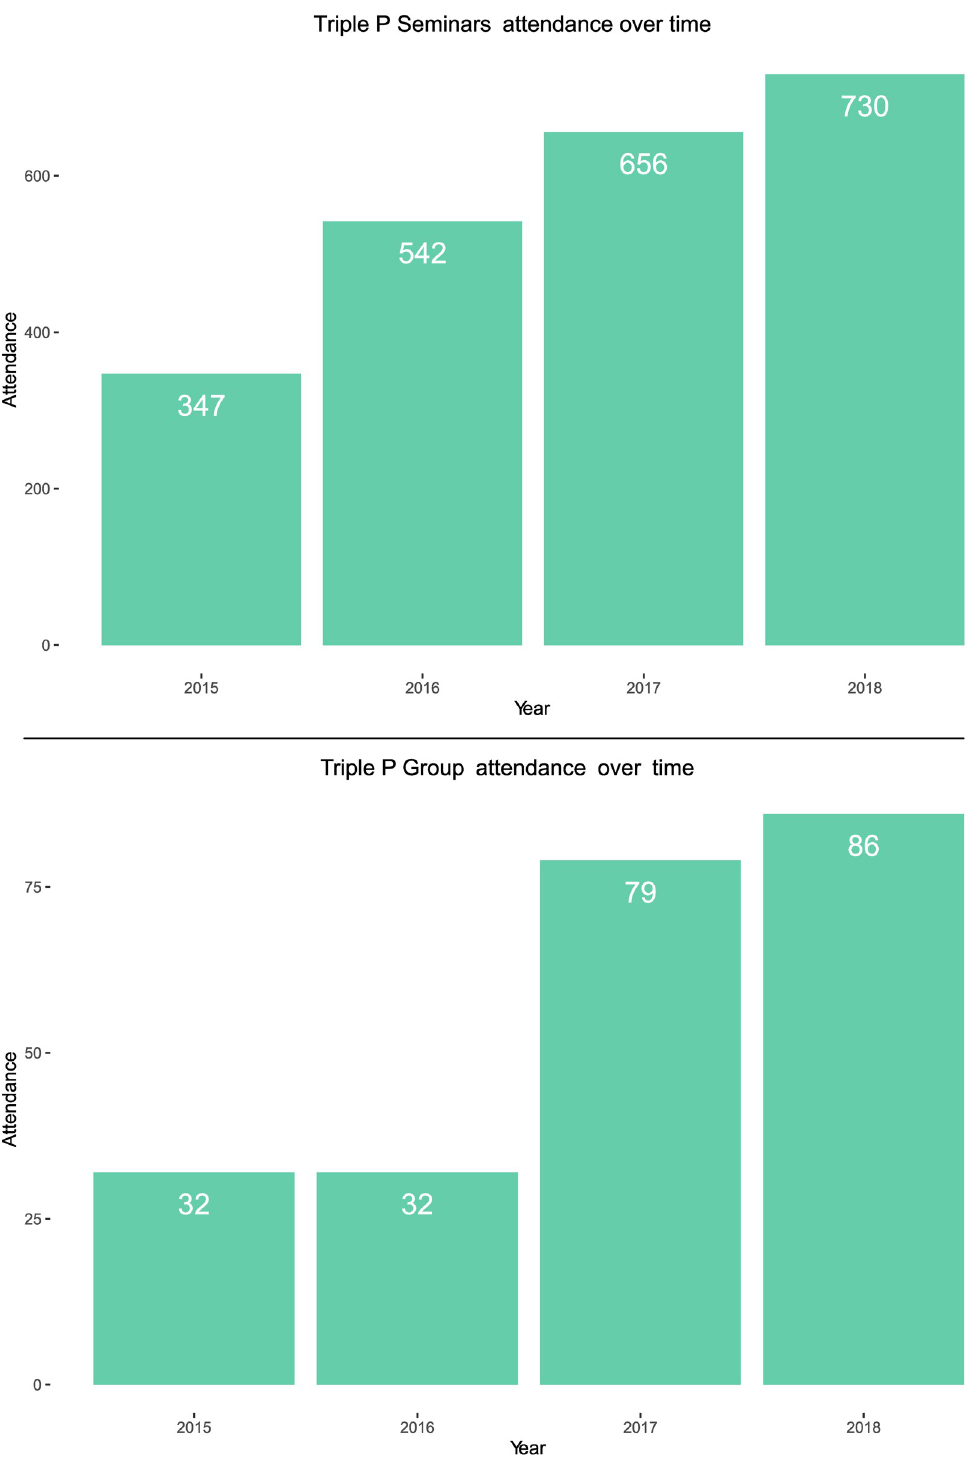
Fig 2. Attendance over time at Triple P seminars and